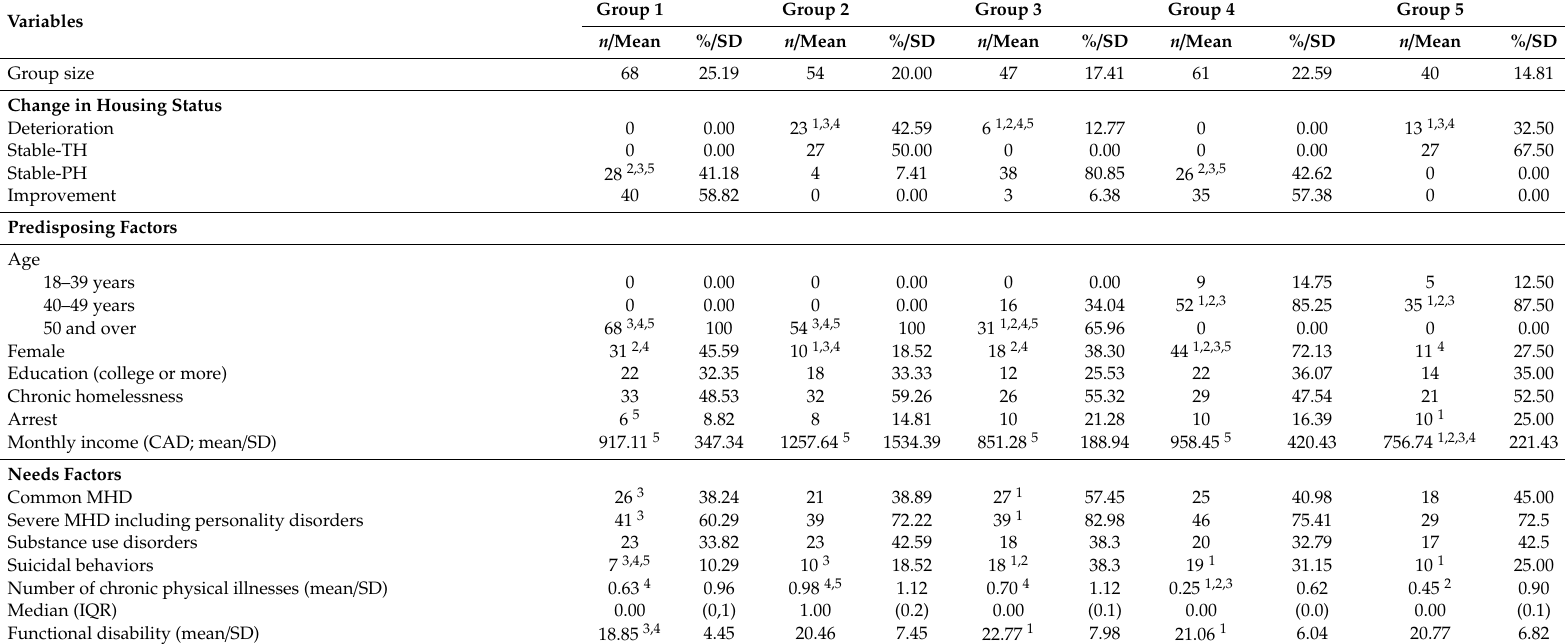
Table 2. Cluster analysis of change in housing status over 12